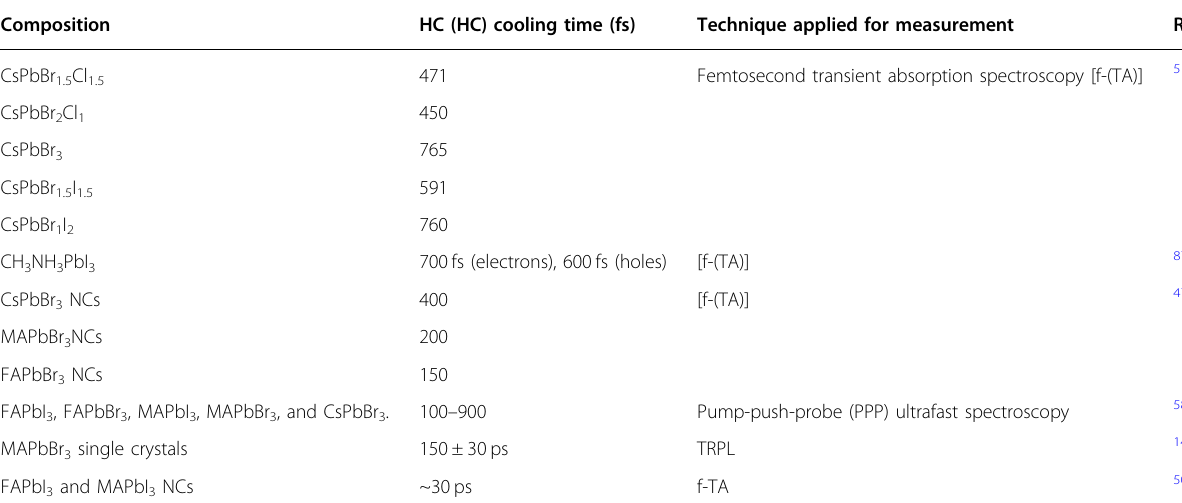
Table 1 HC cooling dynamics in various perovskite materials